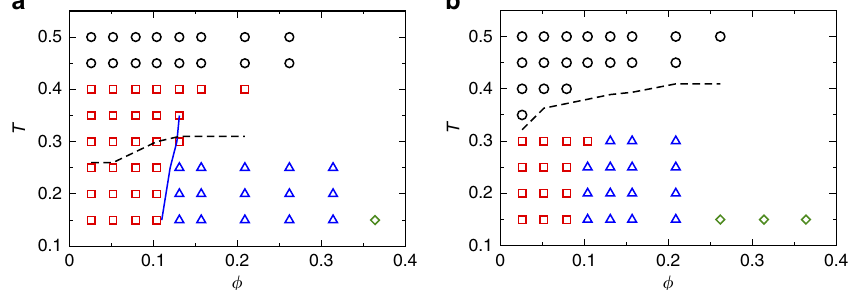
Figure 5 | Summary of the observed phases. The circles indicate the gas phase, the squares the clusters, the triangles the gel states and the diamonds the crystalline states for HS ( a ) and LS ( b ). In HS the solid blue line indicates the geometric percolation of the fibrillar clusters. The dashed lines correspond to the, respectively, weak (for HS) and sharp (for LS) increase in the energy fluctuations measured in MD (NVT) simulations (see Supplementary Fig. 6).